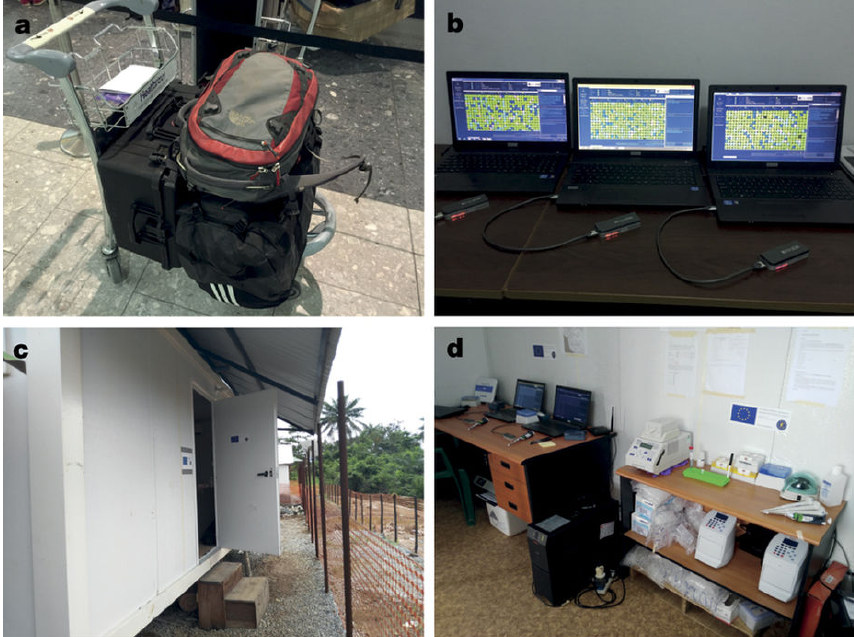
Figure 7. Portable genome sequencing for Ebola surveillance in Guinea. The system consisted of three MinION instruments, four laptops, a thermocycler for PCR, and other tools. Panel ( a ) shows that the authors used aircraft baggage to carry all instruments, reagents and disposable consumables. Panel ( b ) shows that the authors initially established the genomic surveillance laboratory in Donka Hospital, Conakry. Panel ( c ) is used to indicate that they later moved the laboratory to a dedicated sequencing laboratory in Coyah prefecture. Panel ( d ) shows an image of the room inside this laboratory where they separated the sequencing instruments (left side) from the PCR bench (right side). Power to the thermocycler was provided by an un-interruptable power supply, which can be observed in the middle of the room. (Photos were taken by Josh Quick and Sophie Duraffour.) Reprint from